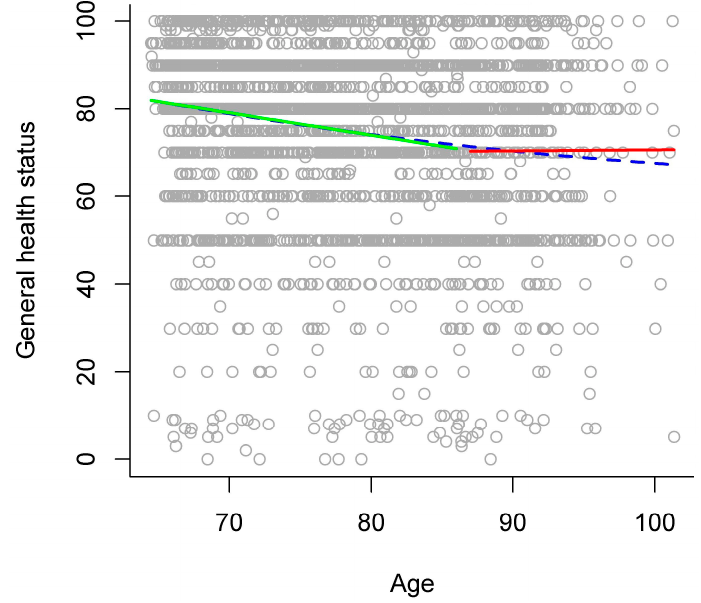
Figure 3. Age relations in general health status. Scores in general health status plotted against chronological age, with different models of age relations: gradual model (blue dashed line) and stage model (young-old adults: green solid line, versus old-old adults: red solid line).